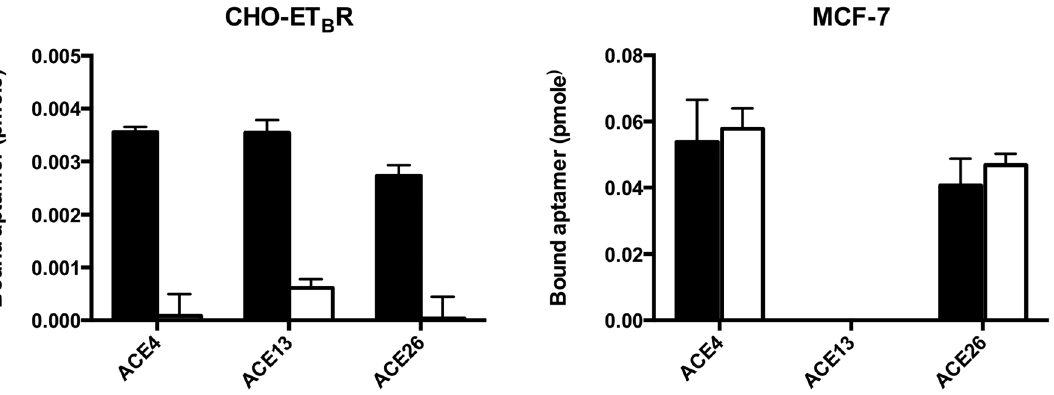
Figure 1. Binding of the ACE4, ACE13, and ACE26 aptamers on CHO-ET B R and MCF-7 cells. Binding assays were performed on CHO-ET B R and MCF-7 cells (left and right panel, respectively) using 25 nM of [ 32 P] 5 9 -end radiolabeled aptamers. Black histograms represent the quantity of bound aptamers on untreated cells. White histograms represent the quantity of bound aptamers on cells pre-incubated with 100 nM of Endothelin-1 for 30 minutes before binding of aptamers. Error bars represent standard deviation of triplicate.